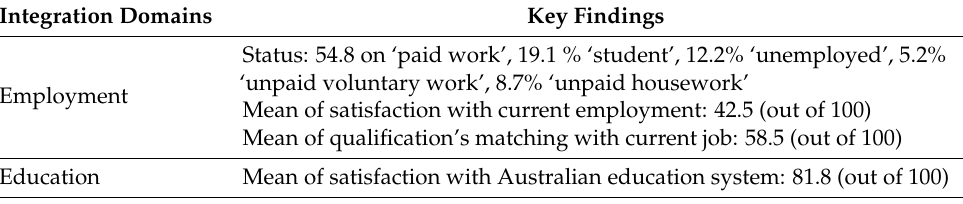
Table 2. Integration domain key findings. Integration Domains Key